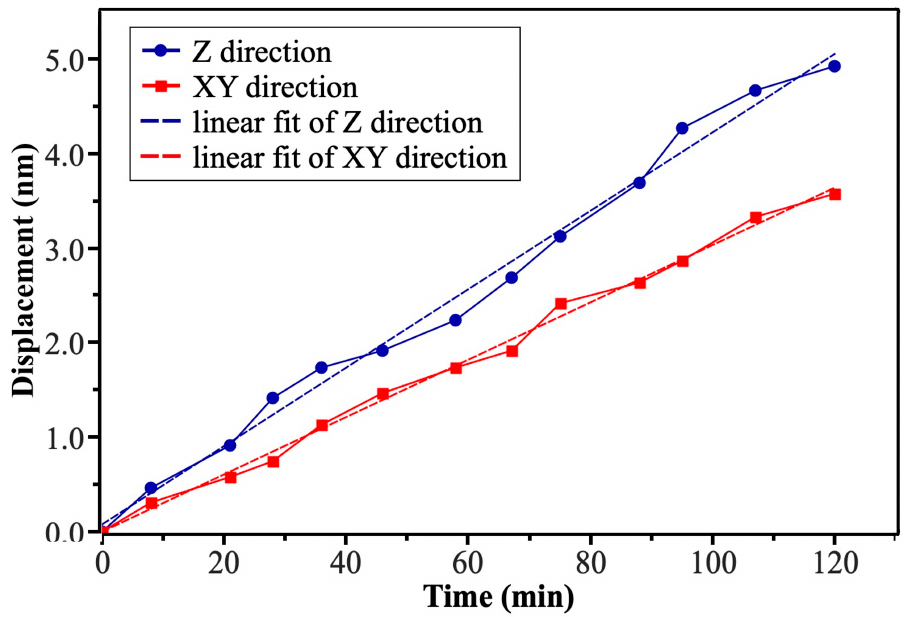
Figure 4. Measurements of drift rates as a function of time at 300 K in the cryogen-free magnet, showing 30.2 and 41.4 pm/min in the X–Y plane and Z direction by linear fitting, respectively.